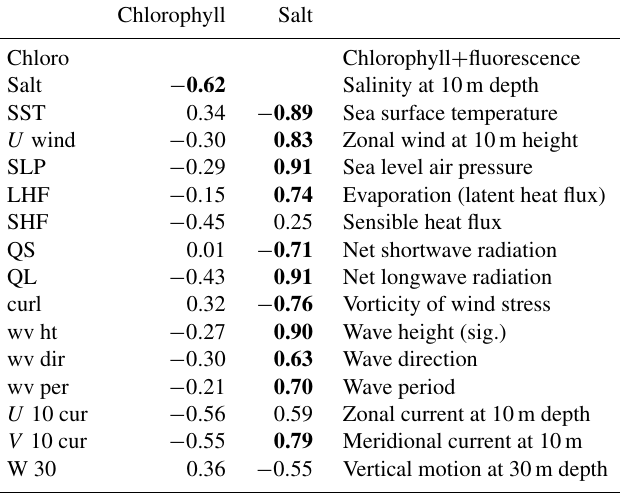
Table 1. Pairwise correlation values for the mean annual cycle averaged over the index area, 2006–2017. N = 46 at 8d resolution; significant values are bold.